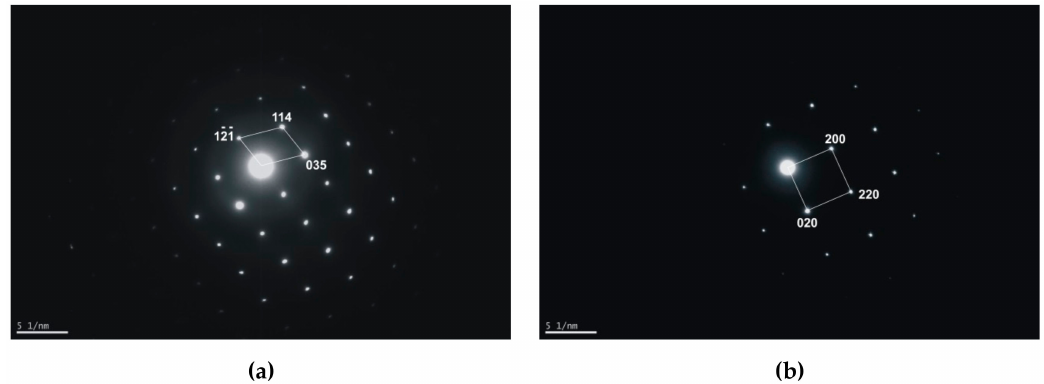
Figure 15. Di ff raction patterns, sample Z6, CT900-2 ◦ : ( a ) (Ti,Nb) 2 S phase from Figure 14, particle a; ( b ) Ti(N,C) phase from Figure 14, particle